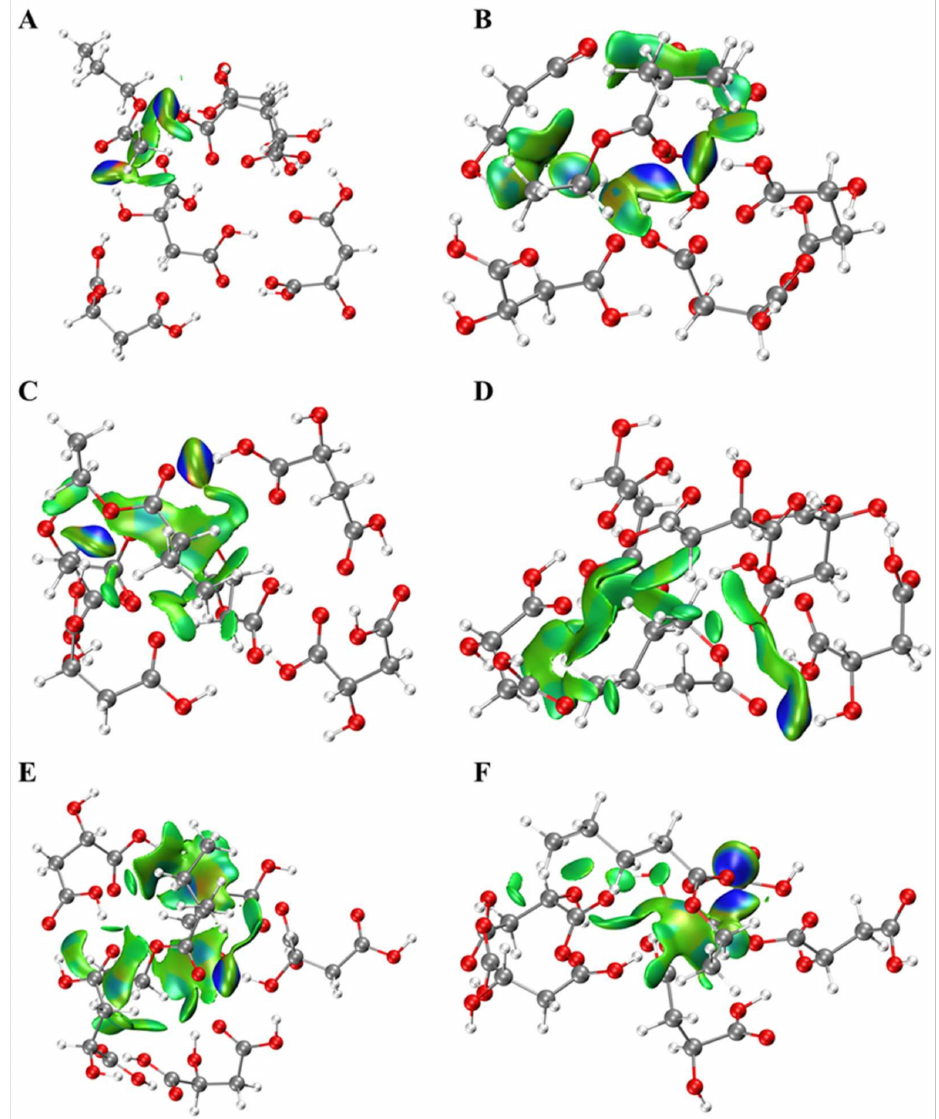
Figure 2. Weak interactions between esters and malic acid. ( A ) C2C3, ( B ) 2MeC3C2, ( C ) C4C2, ( D ) C2C4, ( E ) 3MeC4C2, ( F ) C5C2, H-white, C-gray,